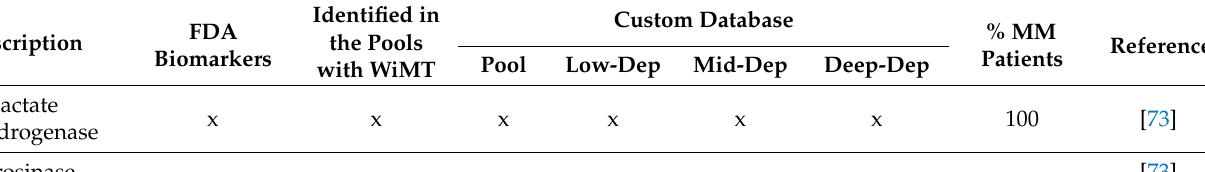
Table 1. Potential plasma/serum malignant melanoma biomarkers.